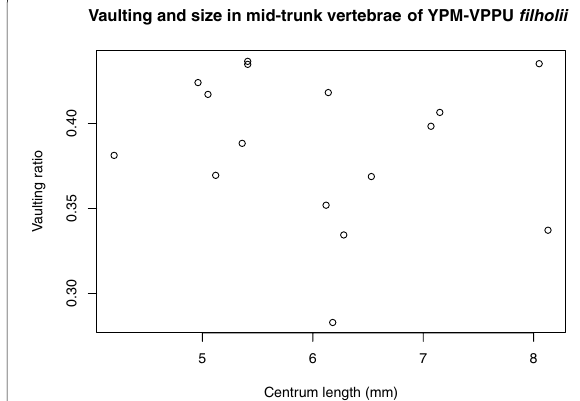
Fig. 89 Relationship between vaulting ratio and centrum length in mid-trunk vertebrae in the YPM collection of Phosphoroboa filholii comb. nov. suggests that these are uncorrelated over a broad ontogenetic range